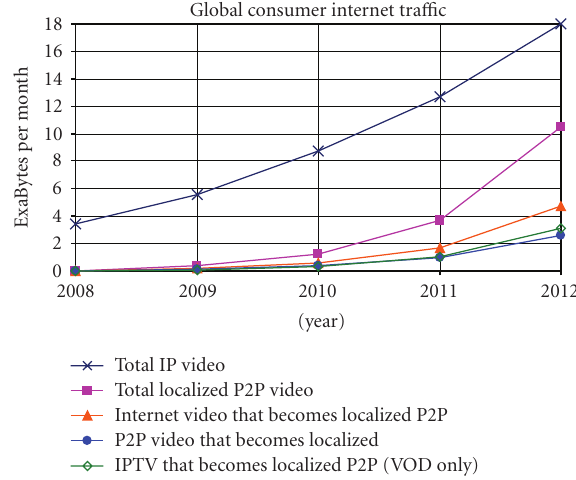
Figure 11: Combined overall projected growth: localized P2P growth and Cisco